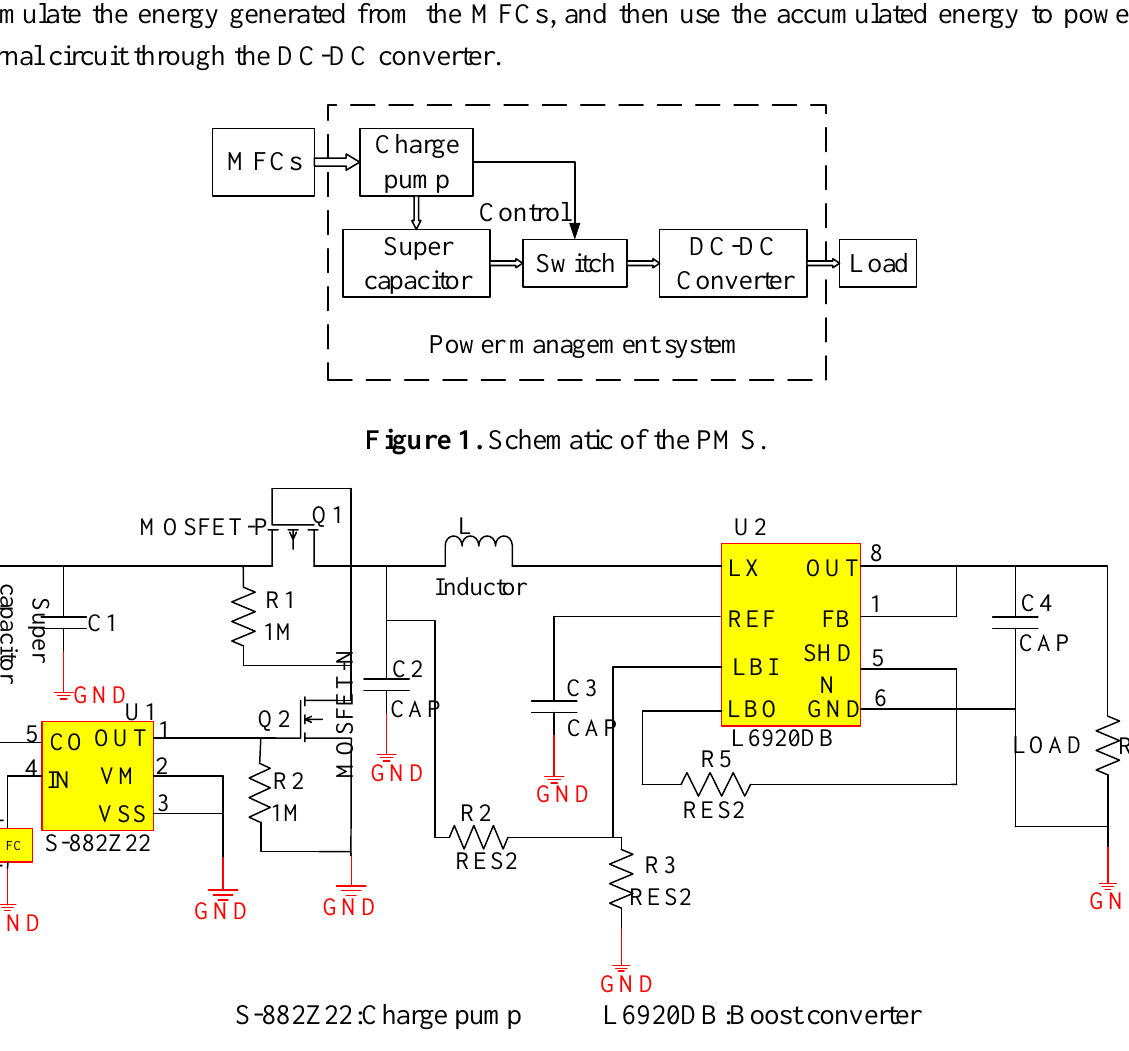
Figure 2. Energy harvesting circuit based on the charge pump and